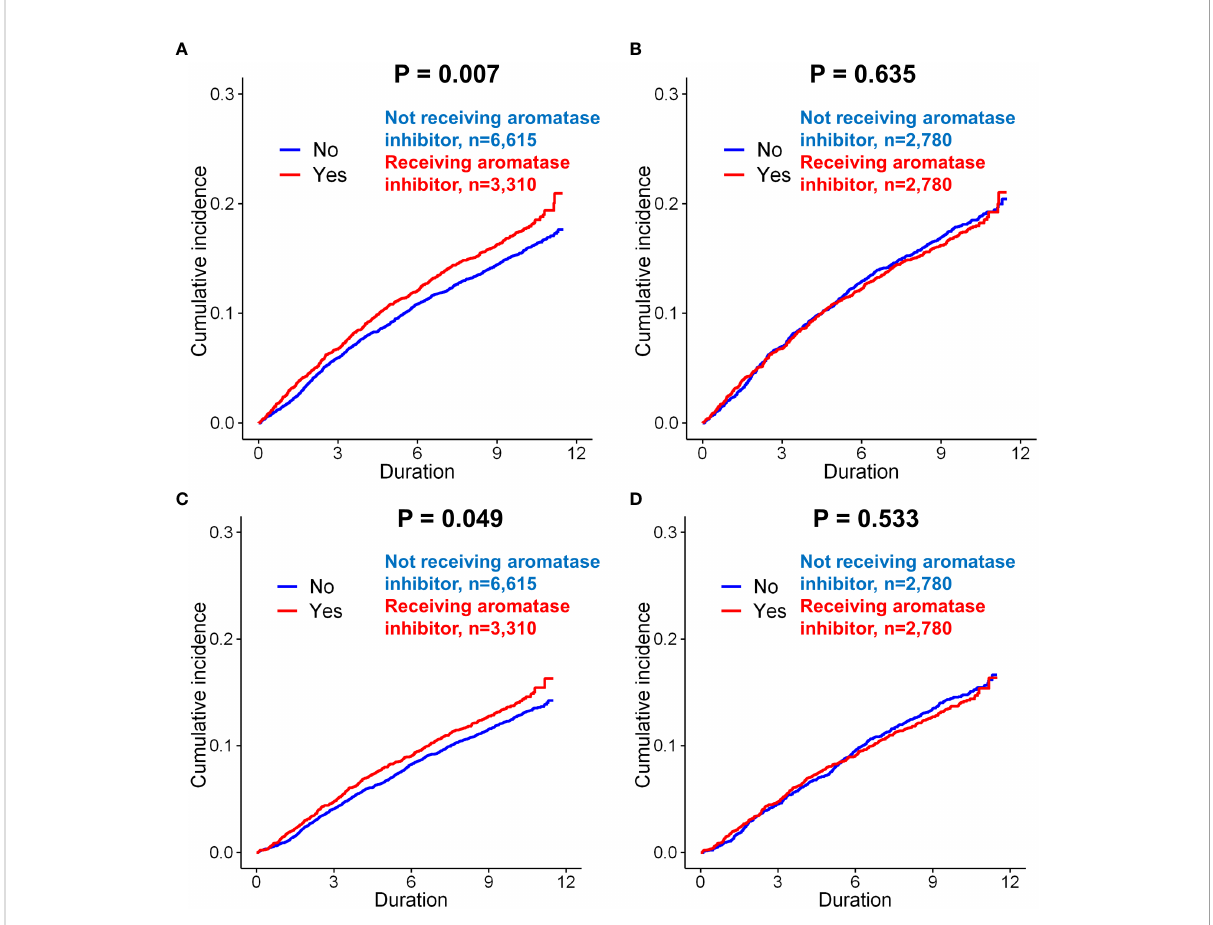
FIGURE 4 Subgroup analysis of incidence of depression in breast cancer patients according to the use of aromatase inhibitors. Before matching, patients administered aromatase inhibitors was exhibited a higher incidence of depression (only diagnosis) than those not administered aromatase inhibitors (A , p = 0.007 ) . However, there was no signi fi cant difference between these two groups after matching (B , p = 0.635 ) . When the incidence of depression (diagnosis + anto-depressant) was analyzed in the patients, the patients administered aromatase inhibitors had a sign fi cantly increased risk of depression than those not administered aromatase inhibitors (C , p = 0.049 ) . However, there was no signi fi cant difference between these two groups after matching (D , p = 0.533 )